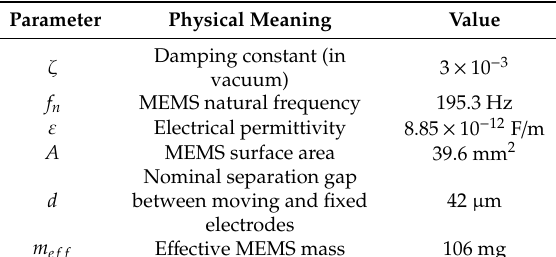
Table 1. MEMS parameters.